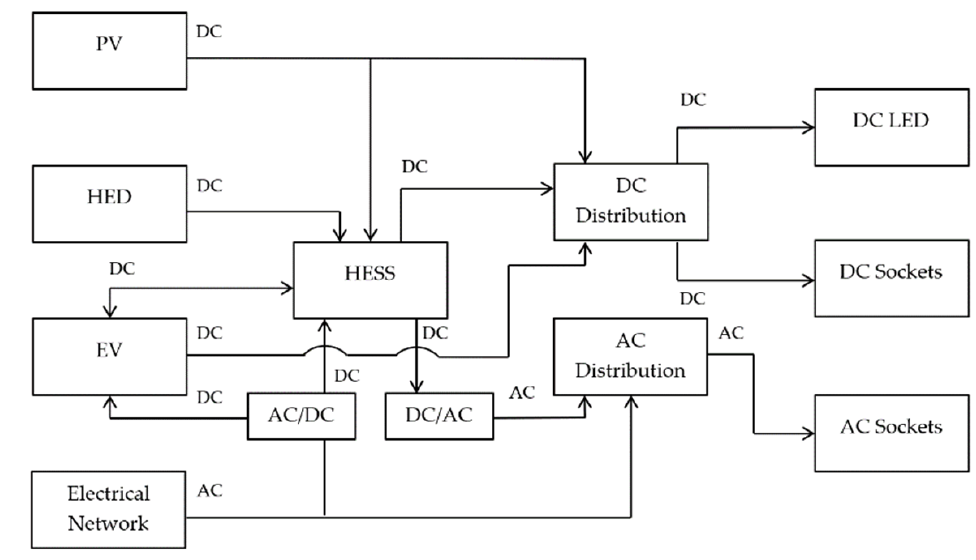
Figure 10. Block diagram of the AC and DC distribution scenario with PV, HED, and EV.